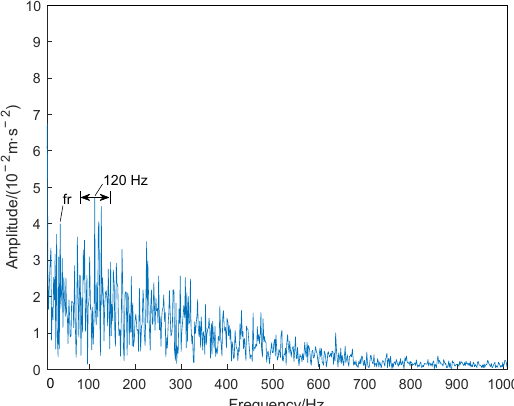
Figure 7. The envelope spectrum of the optimal component.